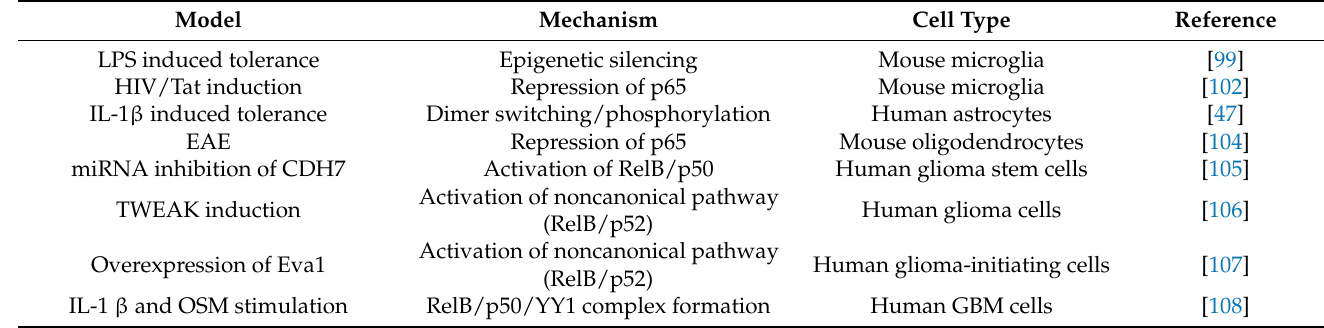
Table 1. Mechanisms of RelB action in the central nervous system